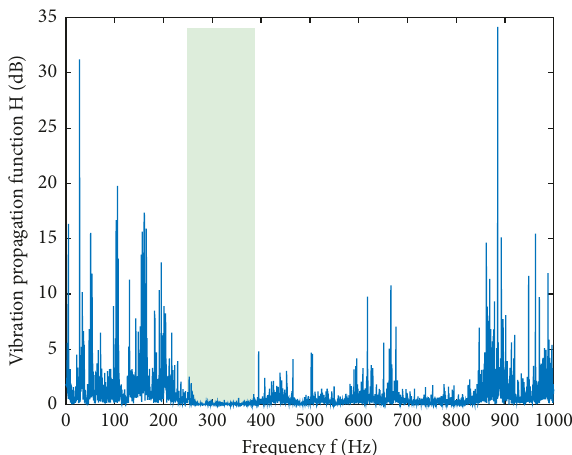
Figure 21: Vibration propagation function of response 2.